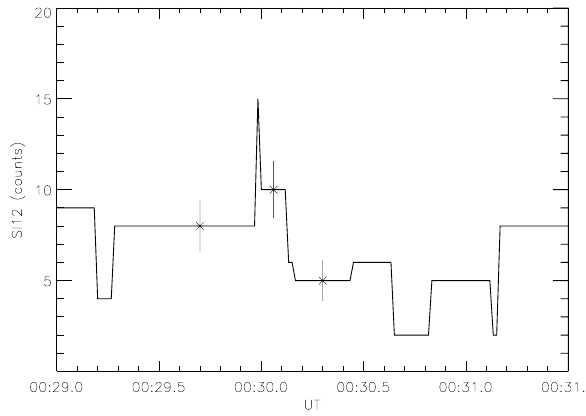
Fig. 9. FUV SI12 observation of a detached subauroral arc on 10 November 2000. The vertical error bars correspond to a one-sigma standard deviation of the count